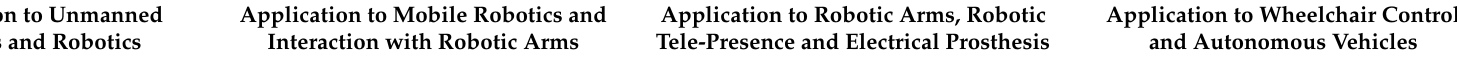
Table 2. BCI applications to